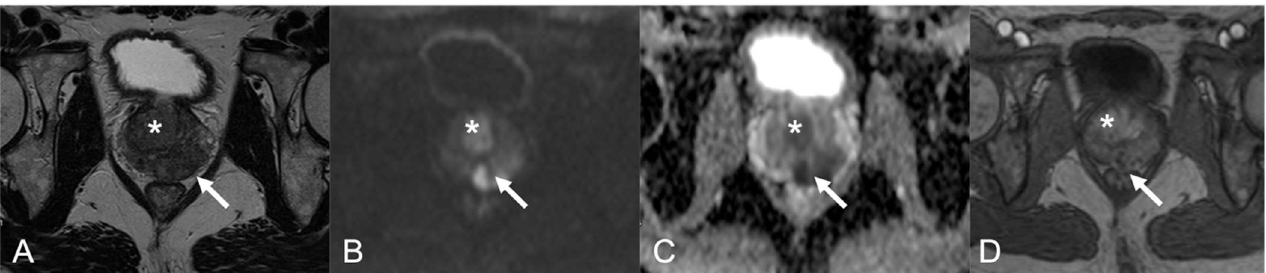
Figure 5. BCG-GP in a 52-year-old patient (case 6). In the T2w image, we can see a lesion in the transition zone (star in ( A )) and an extended peripheral alteration involving the left prostate lobe at the middle/base level (arrow in ( A )) with capsular bulging. In DWI, there is a median area characterized by a markedly restricted diffusivity (arrow in ( B )); also, the transition lesion is hyperintense in DWI (star in ( B )). The 2 findings (star and arrow in C) have low ADC value, especially the peripheral one (arrow in ( C )). In DCE image, the peripheral lesion has a thick peripheral rim enhancement with an avascular core due to caseous necrosis (arrow in ( D )), whereas the transition lesion has an early and prolonged hyperenhancement (star in ( D )), due to the absence of central caseous necrosis. PIRADS v2.1 5 PZpm mid-base left (arrows) and 5 Tza mid-base right (stars).